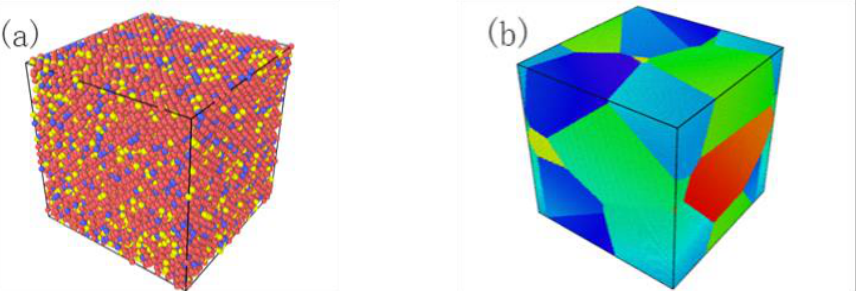
Figure 2. Molecular dynamics model of 316 stainless steel ( a ) single-crystal (SC) model ( b ) 25 nm polycrystalline (PC) model.